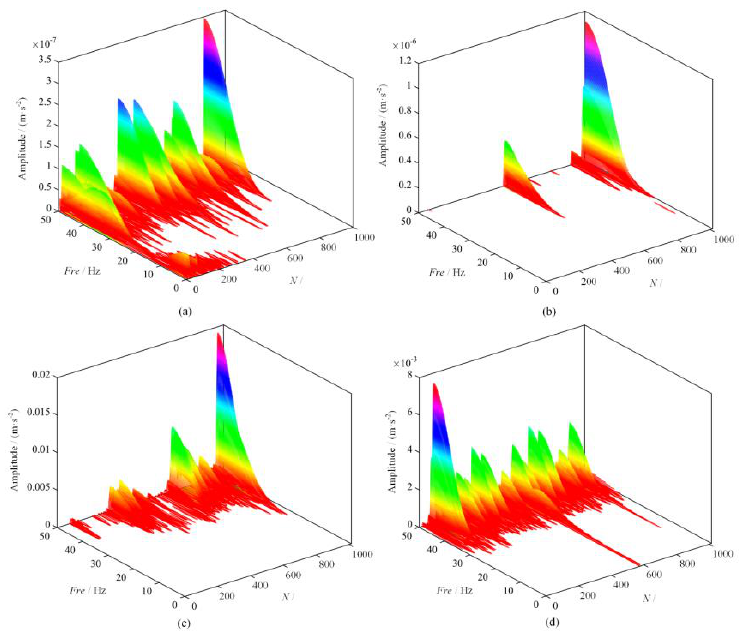
Figure 8. Time/frequency spectrum characteristics of the vibration signal. ( a ) Single water phase, ( b ) Oil – water two-phase, ( c ) Gas – oil – water mixing phase, ( d ) Single gas phase.